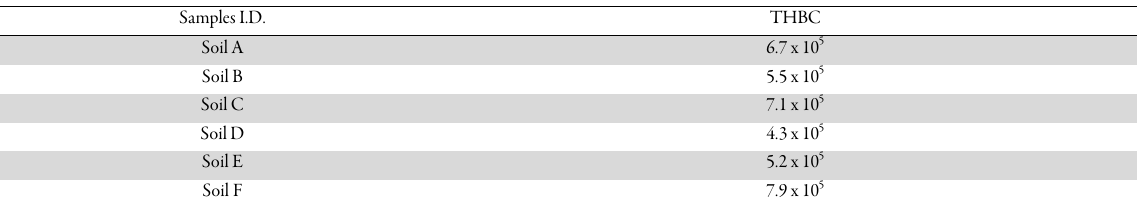
Table 2. Total heterotrophic bacteria count Samples I.D.